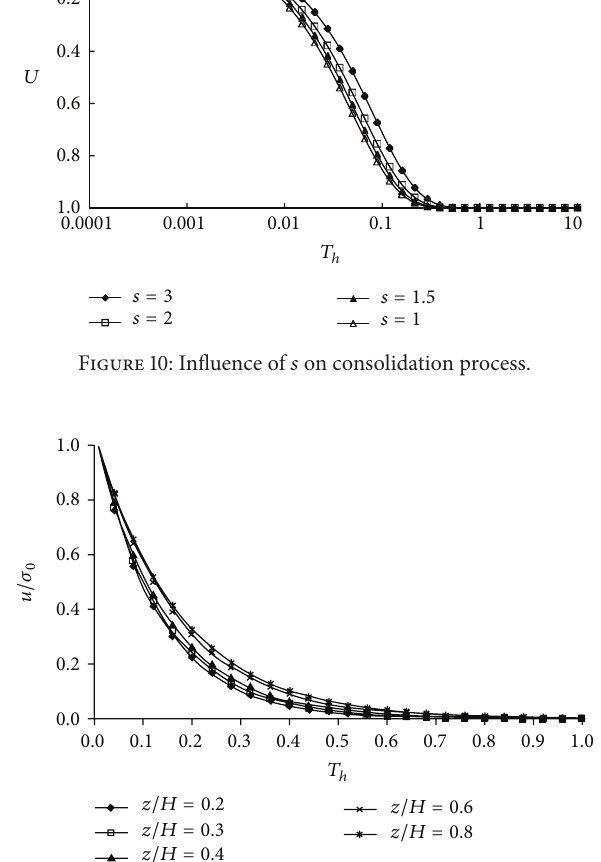
Figure 11: Dissipation curves of average pore-pressure at different depth in